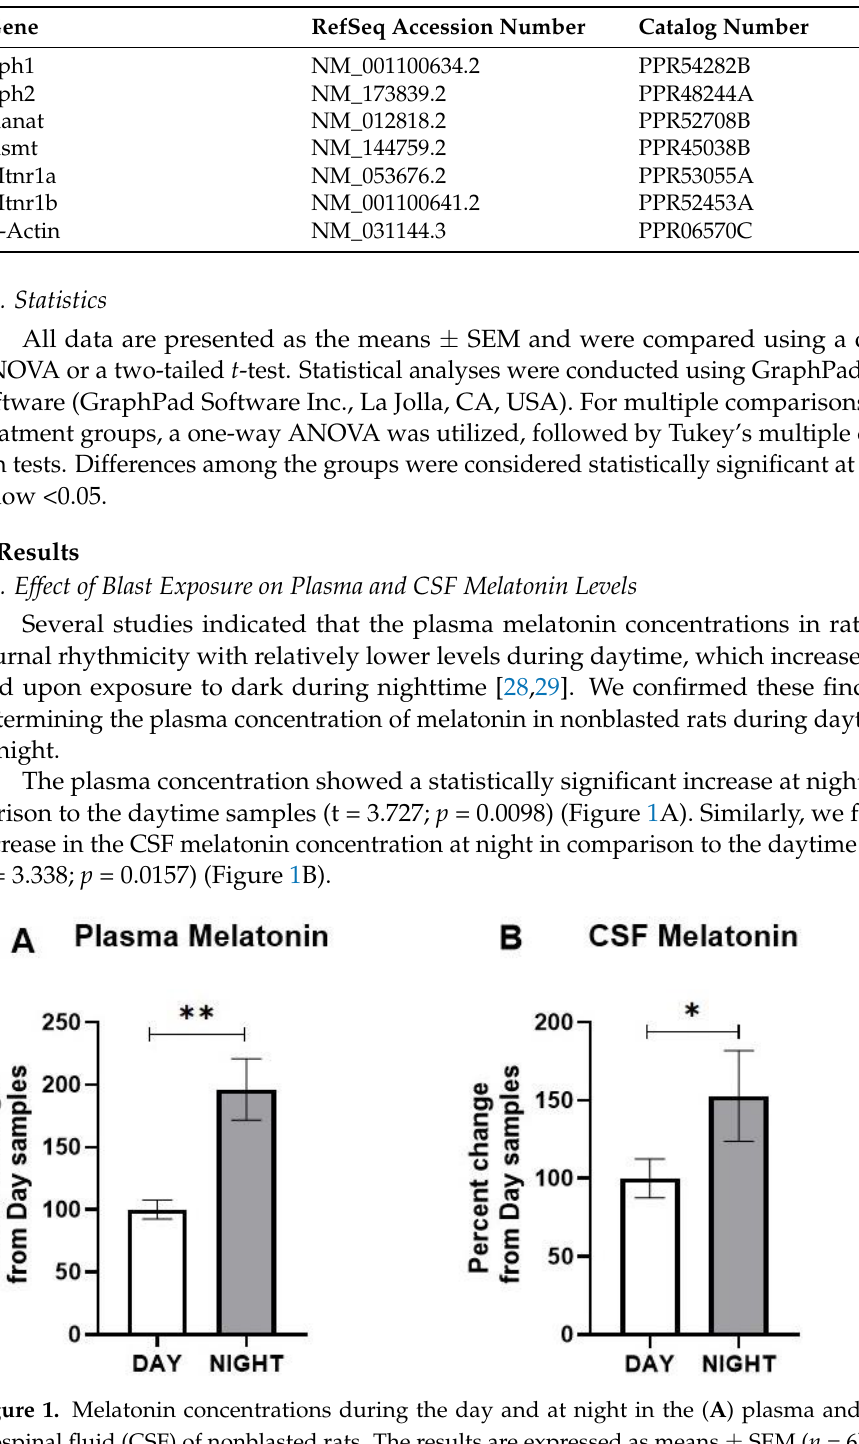
Table 1. List of primers.